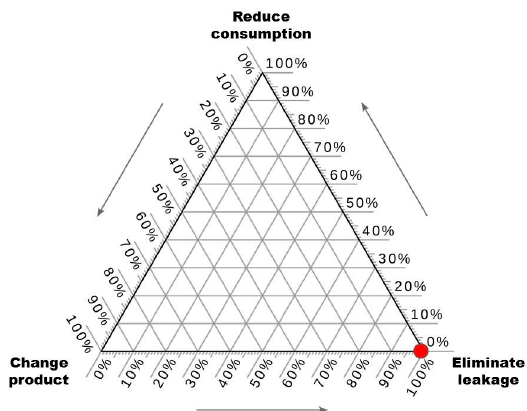
Figure 3. Driving solely a waste collection approach.